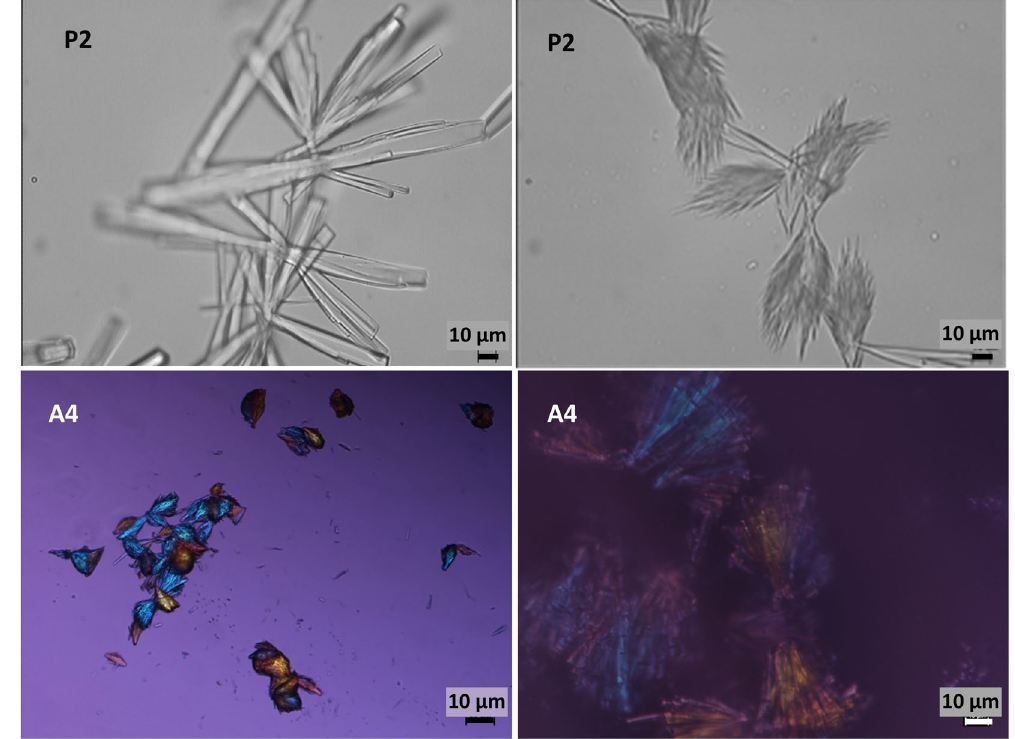
Figure 5. Crystal precipitation of inorganic calcium and inorganic phosphate in PN solutions P2 and A4.